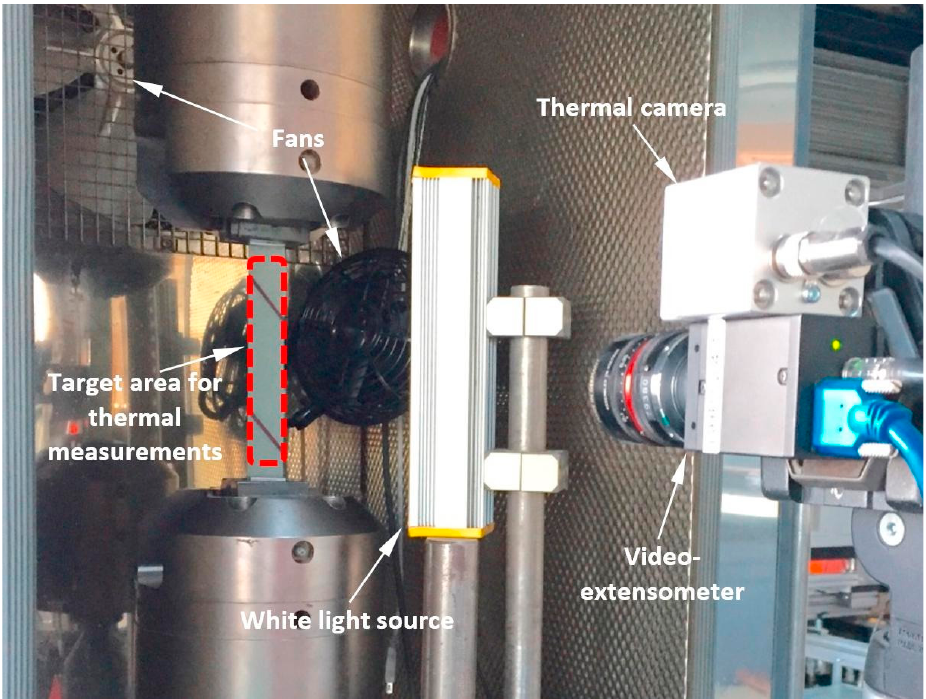
Figure 51. The experimental setup including coolant system for fatigue testing of angle-ply glass/epoxy structures, adapted with permission from Ref. [77]. Copyright © 2018 Elsevier